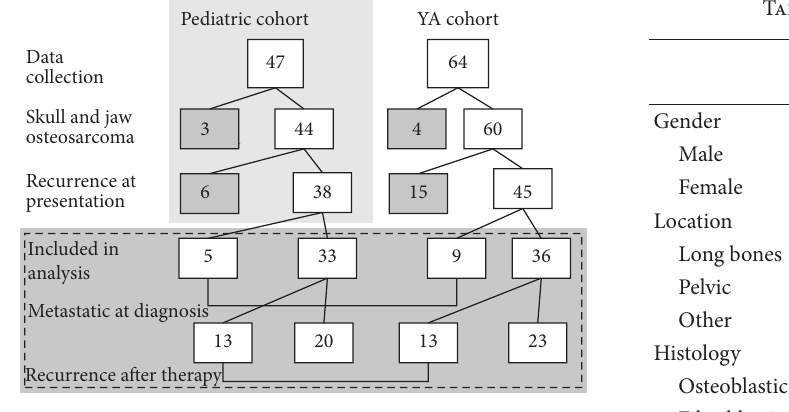
Figure 1: Patient cohorts (pediatric and YA). Of the 83 patients included in our analysis, 14 had metastatic disease at diagnosis, and 26 patients went on to have recurrence.